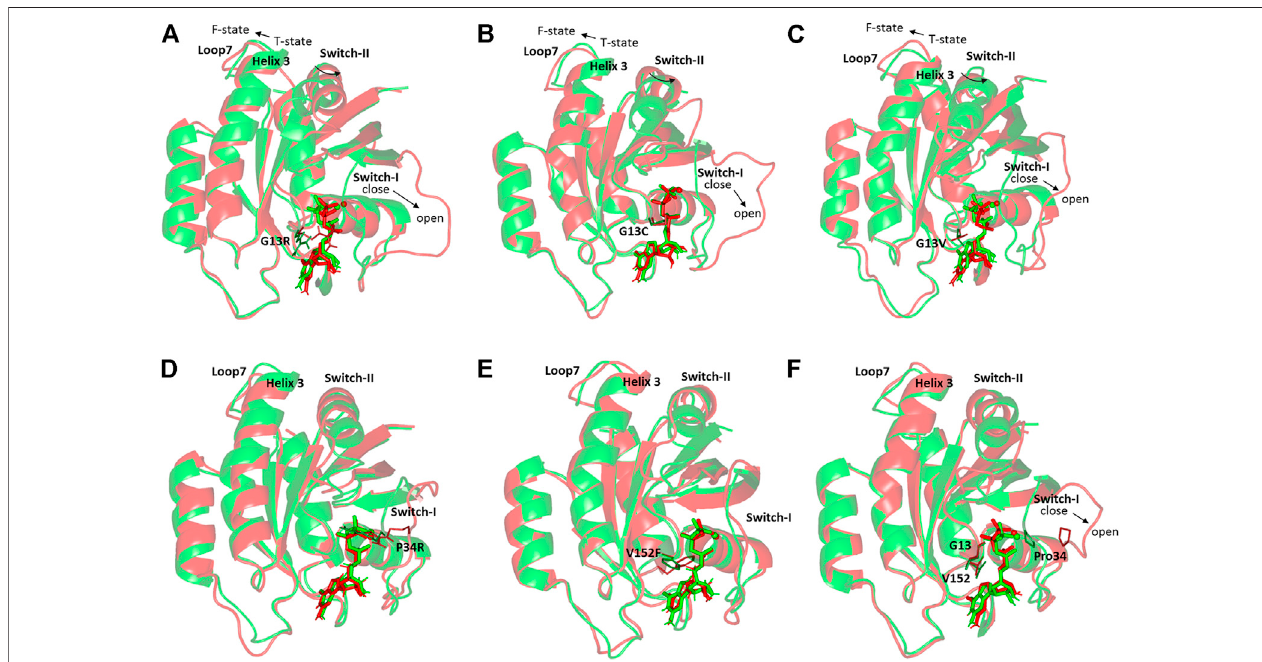
FIGURE4| Conformationalanalysisofsimulated GTPase NRAS-GTP complexesat thestartand fi nal molecular dynamicstimeframes.Superimposed 0and 100- ns shots of the simulated NRAS complexes; (A) model #1, (B) model #2, (C) model #3, (D) model #6, (E) model #16, (F) native holo protein. Complexes are shown in green and red cartoons respective to the initial and last extracted frames. Ligands (sticks) and SNP residues (lines) are presented in colors corresponding to extracted